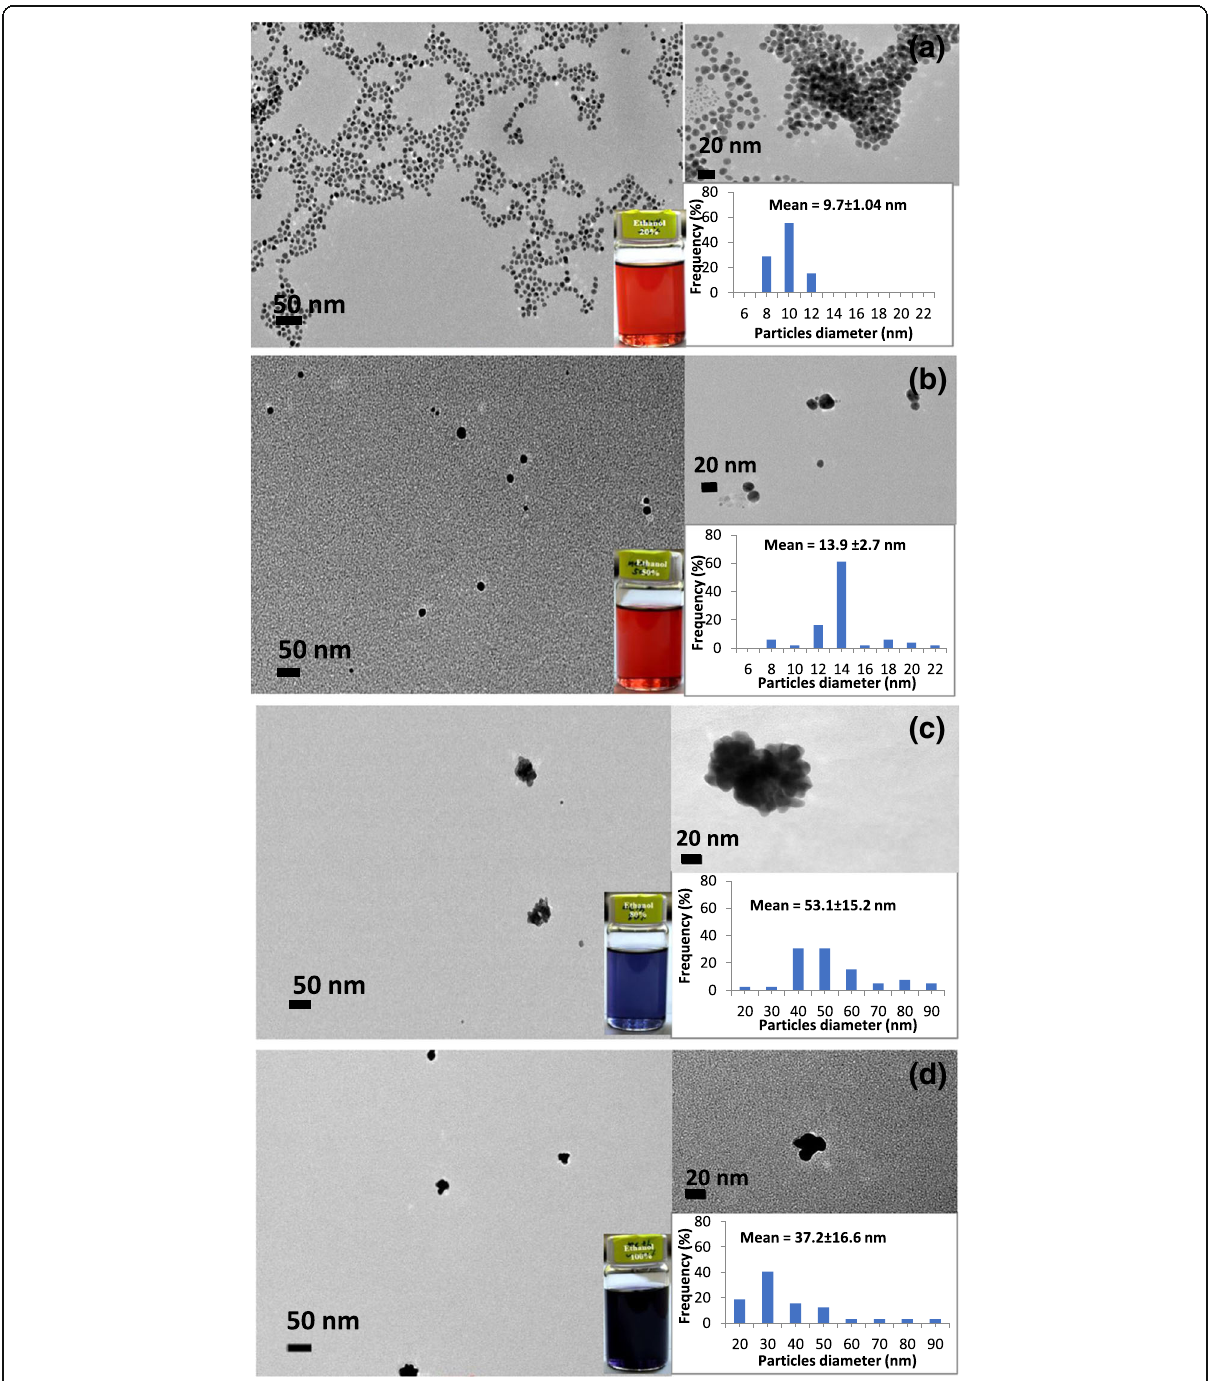
Fig. 6 Colors, TEM images, and size distribution of the produced GNP suspension in various volume percentage of ethanol to water with ( a ) 20%, ( b ) 50%, ( c ) 80%, and ( d ) 100%